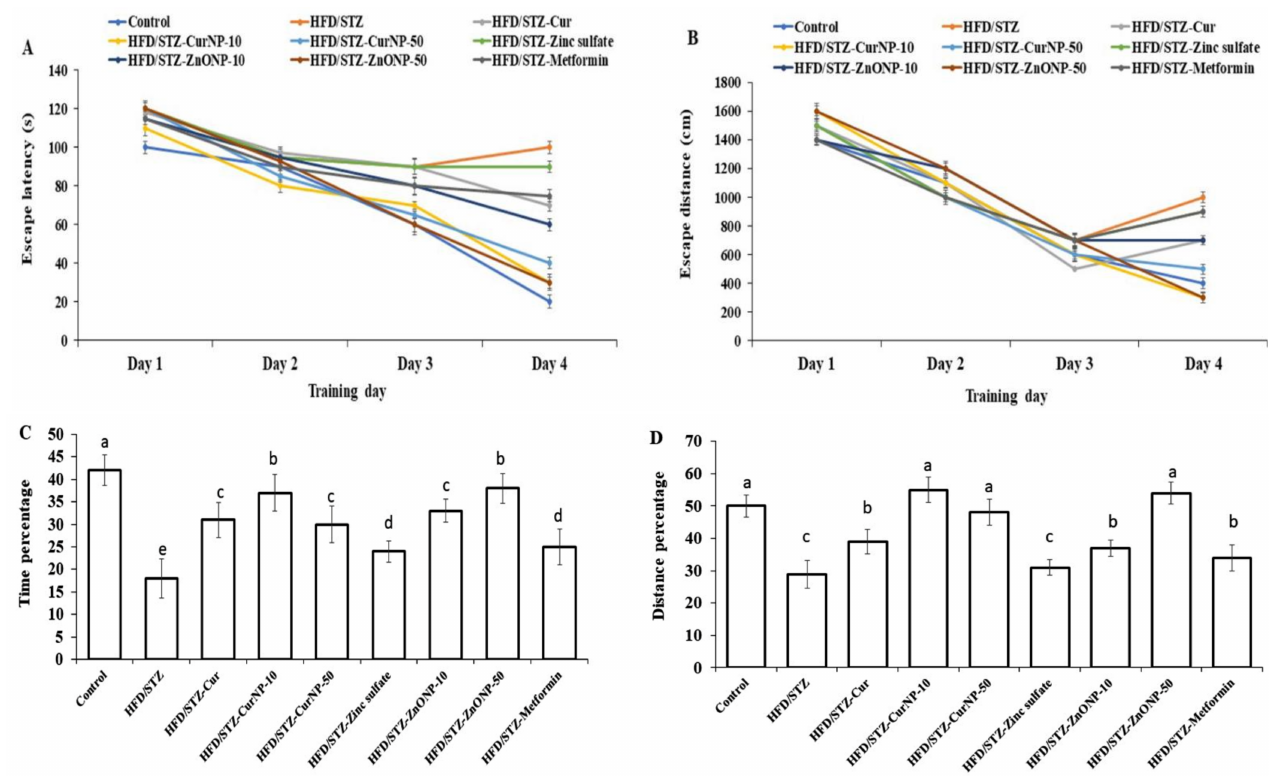
Figure 2. Effects of ZnONP and CurNP on memory impairment in rats. The Morris water maze (MWM) was used to test rats’ memories by measuring ( A ) escape latency and ( B ) escape distances. A probe test was used to analyze the maintenance of memory in the MWM by measuring the percentage of ( C ) time spent and ( D ) distance swum in the target quadrant. Three independent experiments were performed. Data are expressed as mean ± SEM ( n = 8); means with different letters (a–e) in each bar are significantly different ( p < 0.01), in Figure 2C the largest data value take the letter (a) and the smallest data value take the letter (e) and in Figure 2D the largest data value take the letter (a) and the smallest data value take the letter